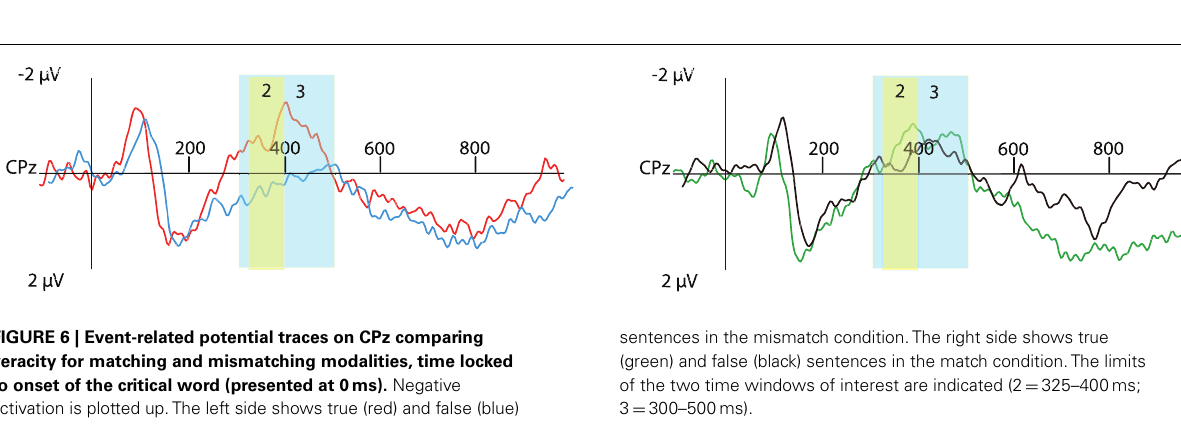
sentences in the mismatch condition.The right side shows true (green) and false (black) sentences in the match condition.The limits of the two time windows of interest are indicated (2 = 325–400ms; 3 =